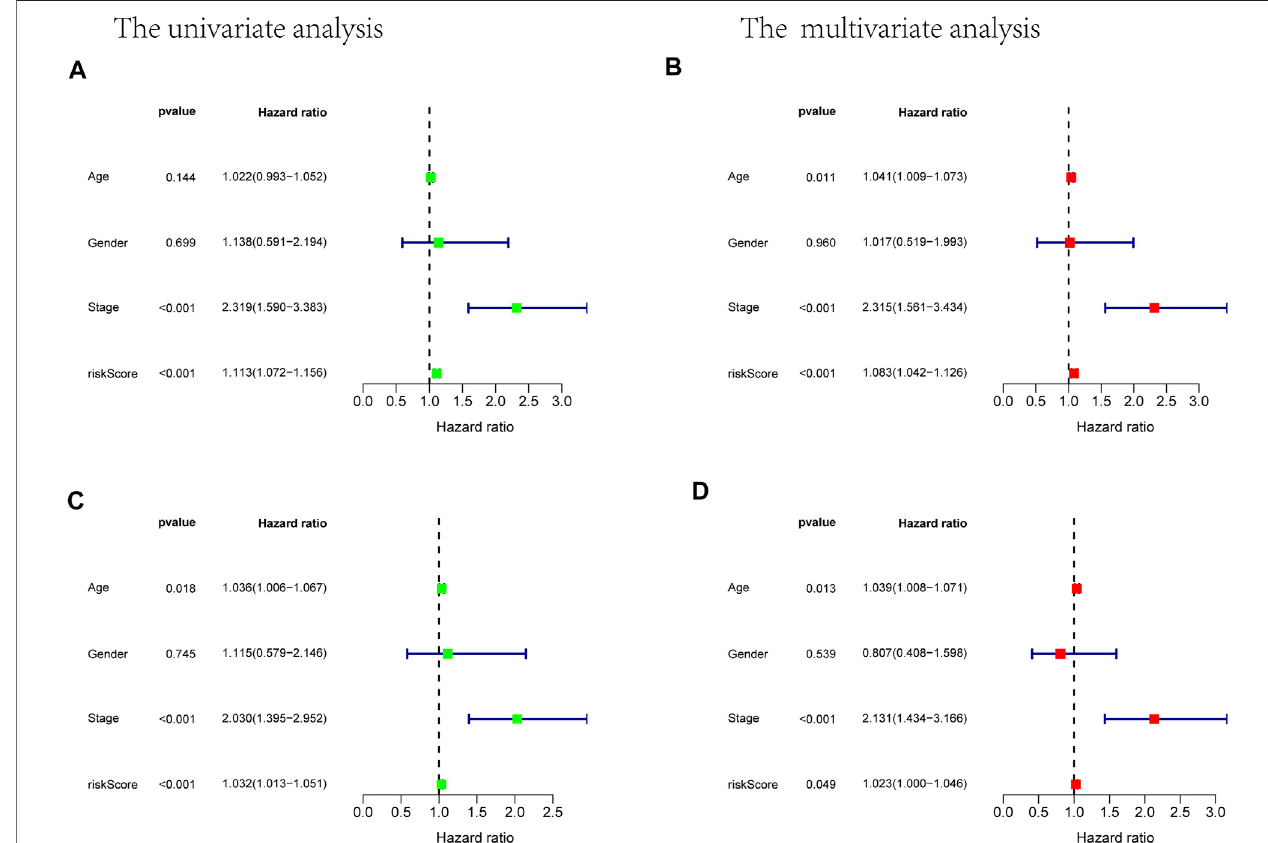
FIGURE 6 | Univariate and multivariate Cox analysis considering riskscore, age, gender, and stage, in training cohort (A,B) and test cohort (C,D) .